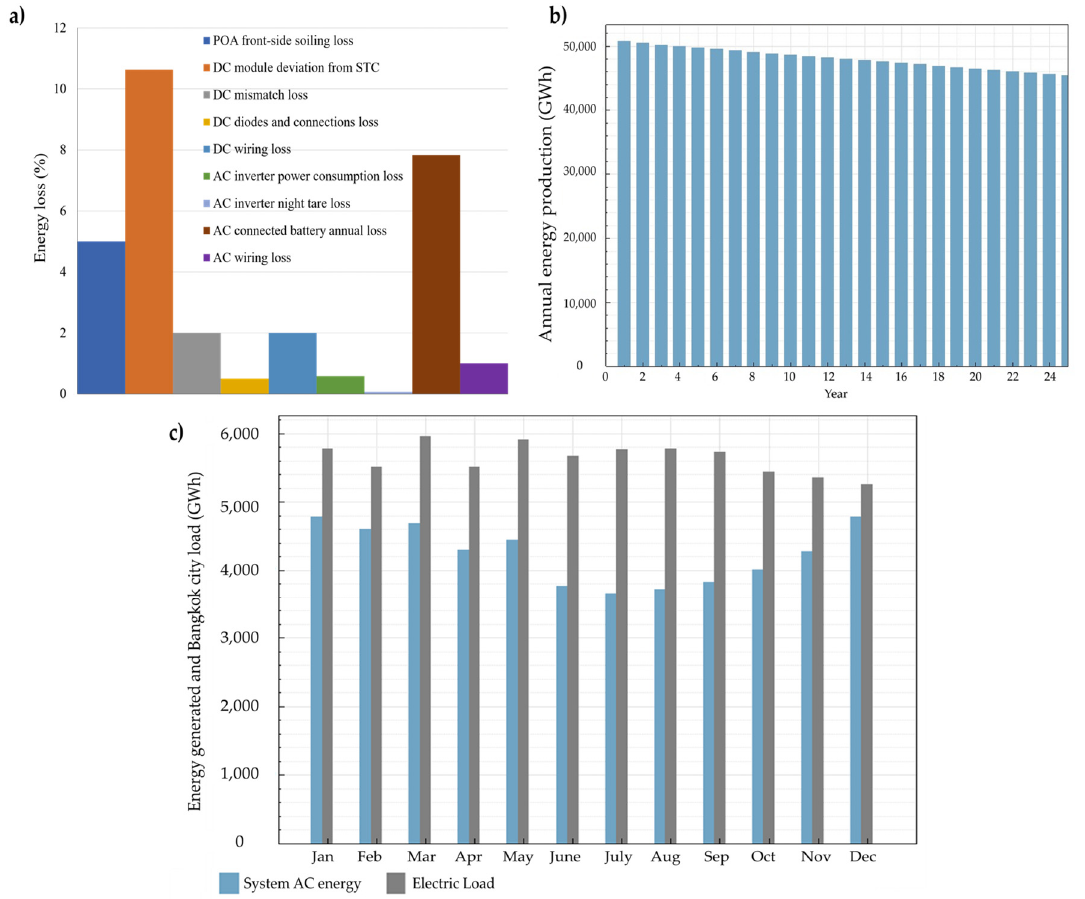
Figure 7. Results of the analysis for Scenario E. ( a ) Energy loss. ( b ) Annual PV generation over the project period (PV capacity: 36.8 GW). ( c ) Monthly PV generation in comparison to electricity demand in Bangkok City.